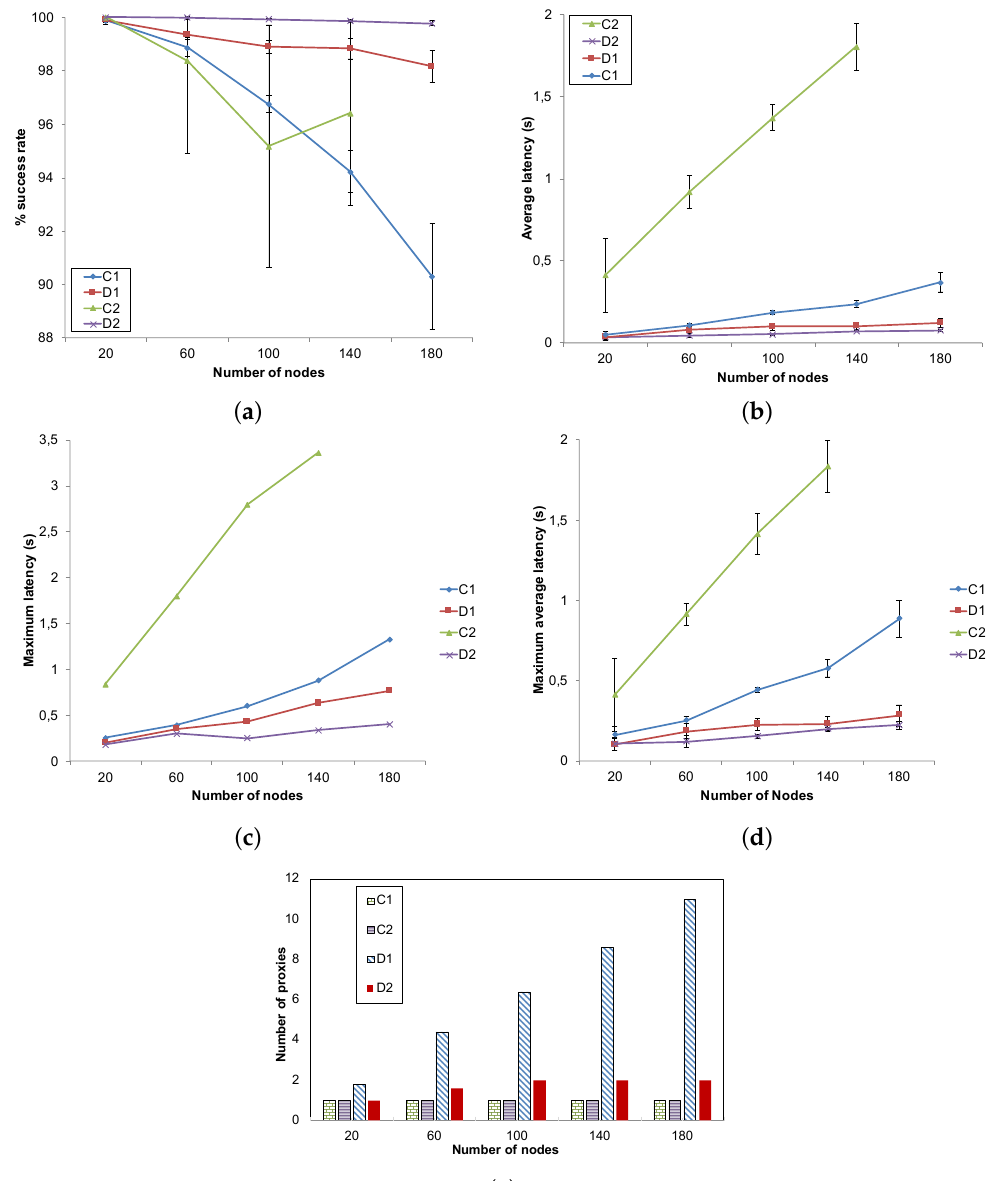
Figure 4. Performance for variable number of nodes. ( a ) Success rate; ( b ) Average latency; ( c ) Maxi- mum latency; ( d ) Maximum average latency; ( e ) Number of